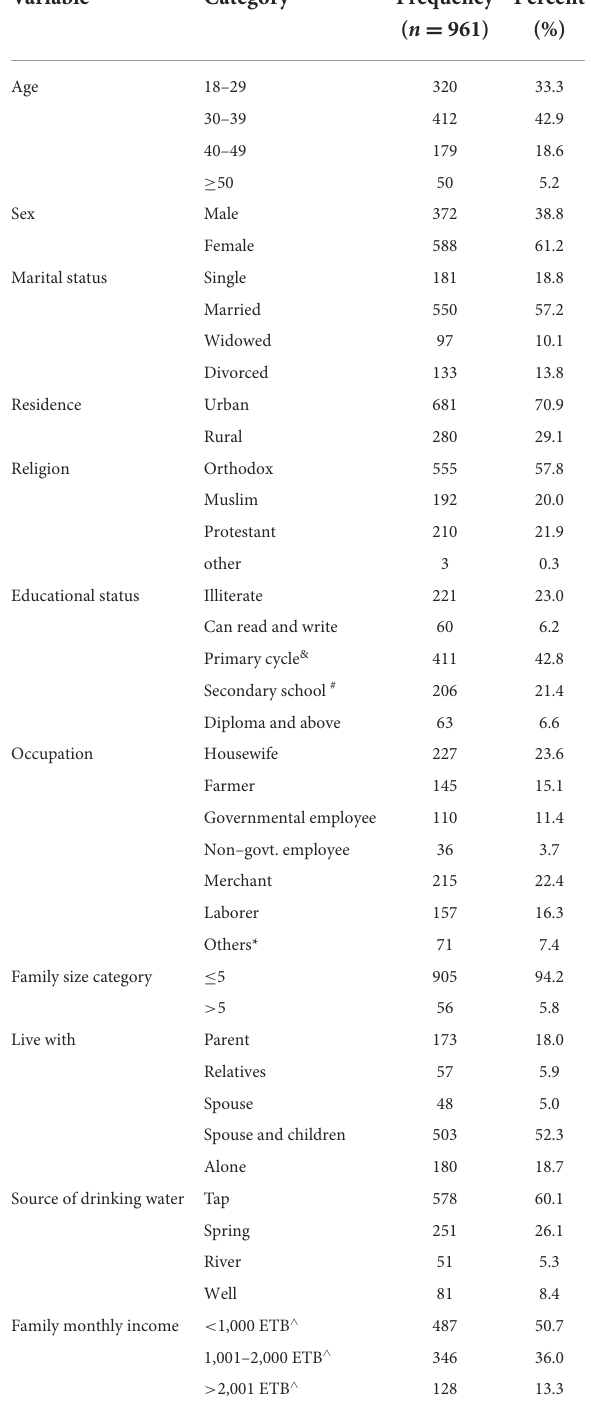
TABLE 1 Socio-demographic characteristics of the study participants at Bench Maji Zone, southwest, Ethiopia, 2018.